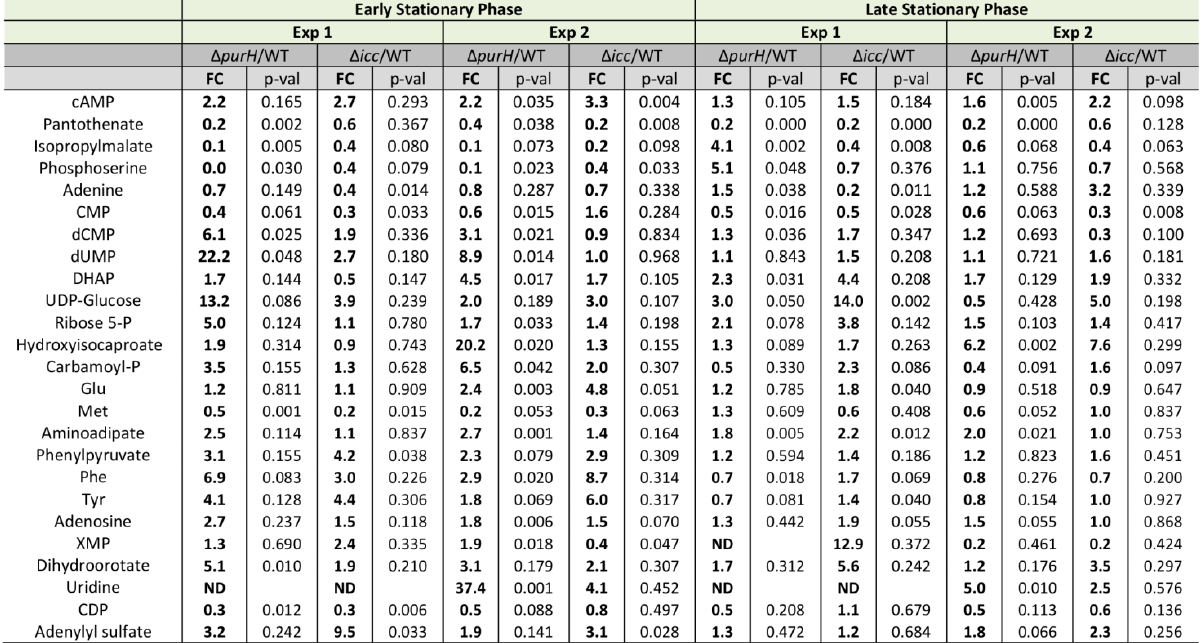
TABLE 5. Increased cAMP levels account for a subset of perturbations observed in a Δ purH